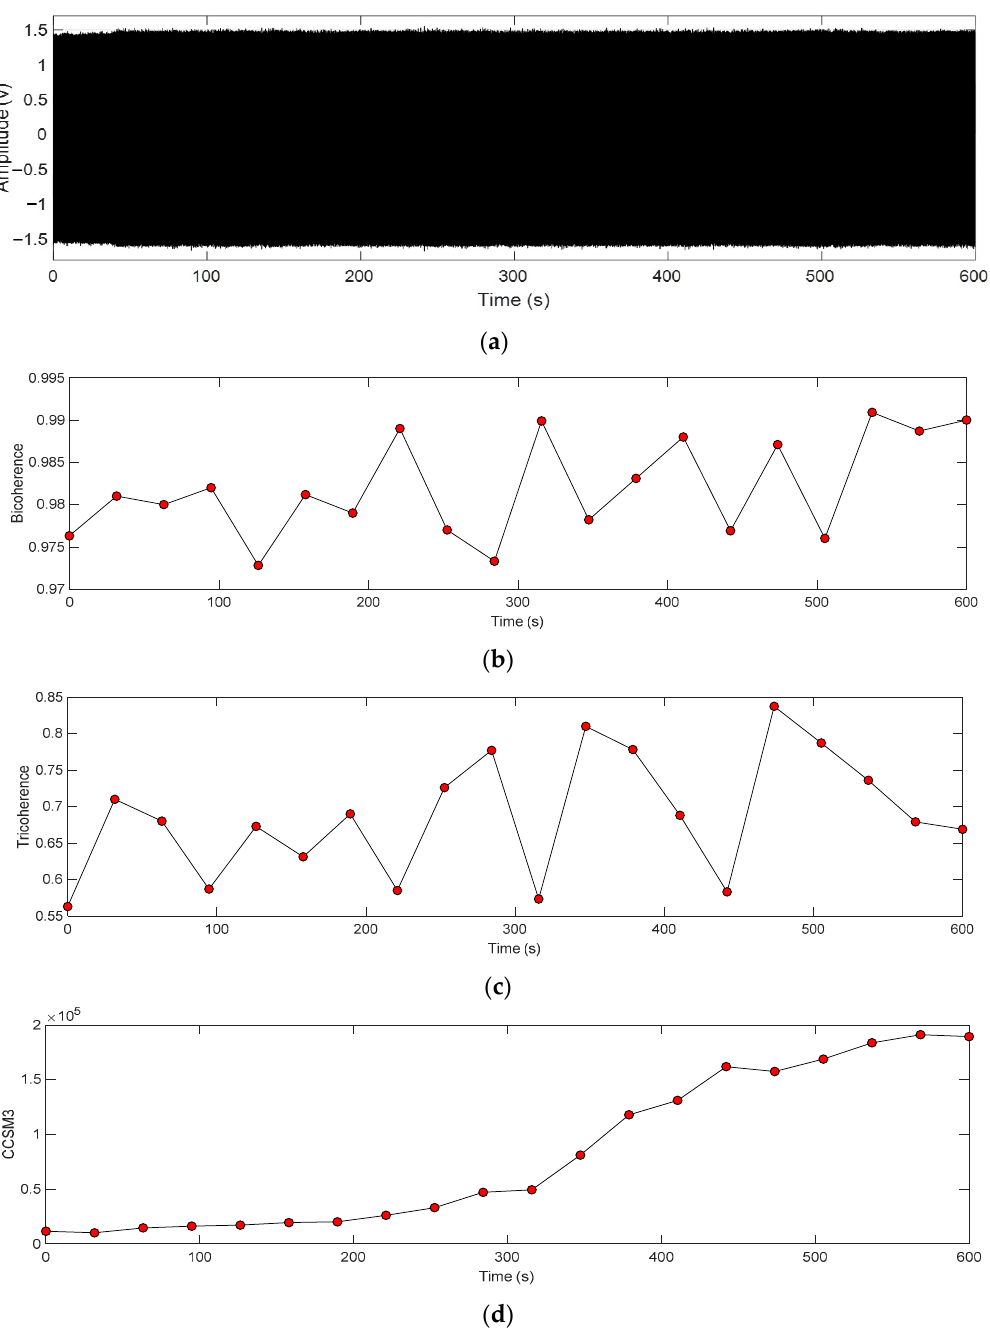
Figure 11. ( a ) A time signal of a motor current recorded during a transition from a normal tracking to a non-drive side mis-tracking, ( b ) The estimated bicoherence values, ( c ) The estimated tricoherence values, ( d ) The estimated CCM3 values.